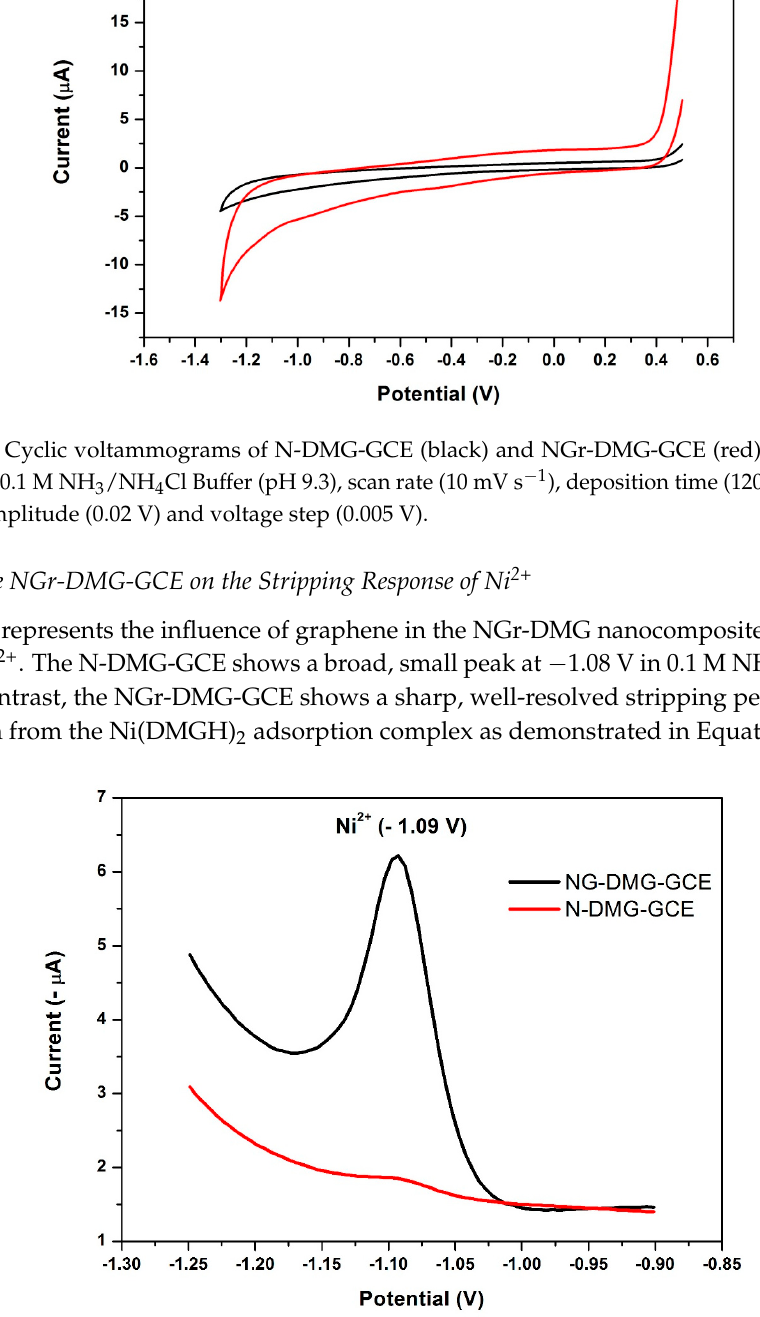
Figure 11. SW-AdCSV of 20 µg L − 1 Ni 2+ at N-DMG-GCE (red) and NGr-DMG-GCE (black) with a characteristic reduction stripping potential of − 1.09 V. Supporting electrolyte (0.1 M NH 3 /NH 4 Cl Buffer (pH 9.3)), deposition potential ( − 0.7 V), deposition time (120 s), frequency (20 Hz), amplitude (0.02 V) and voltage step (0.005 V).